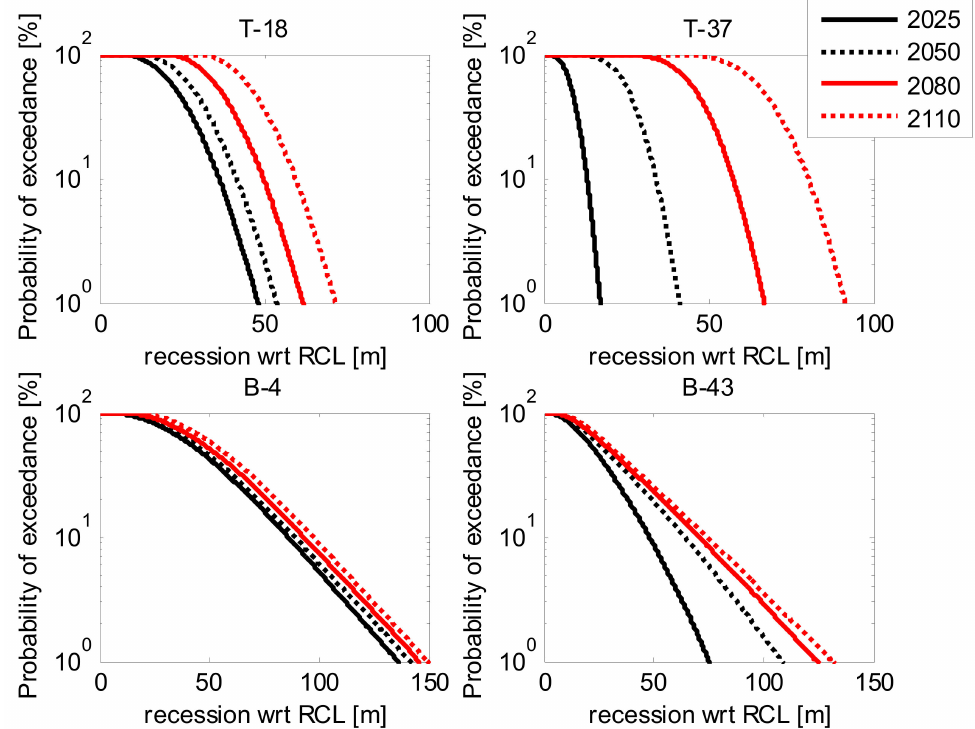
Figure 16. Exceedance probability curves of coastal recession for selected profiles in Trincomalee and Batticaloa districts for different